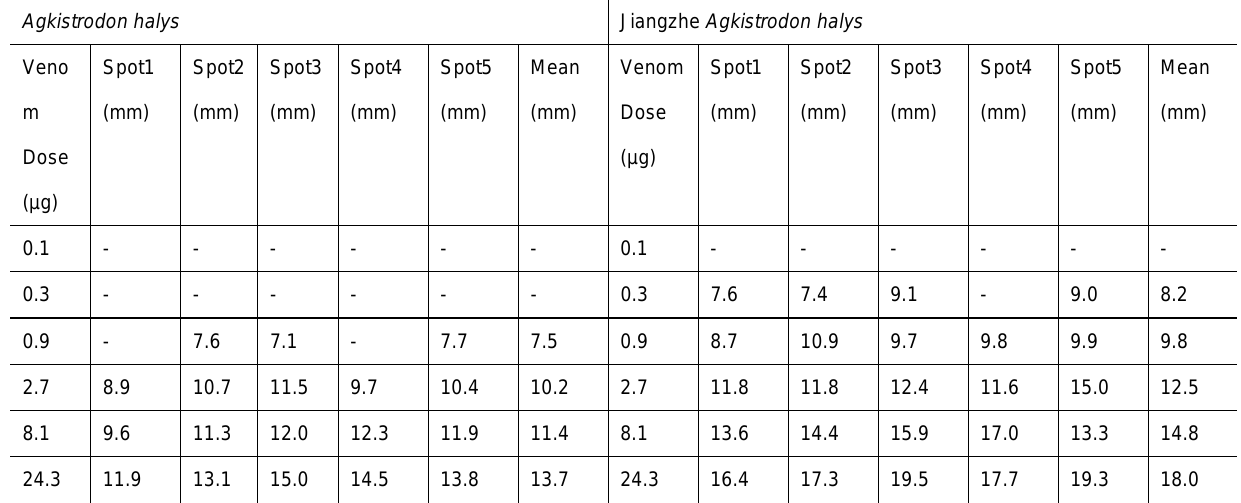
Table 1: Diameters of response spots triggered by the intracutaneously injected venoms.